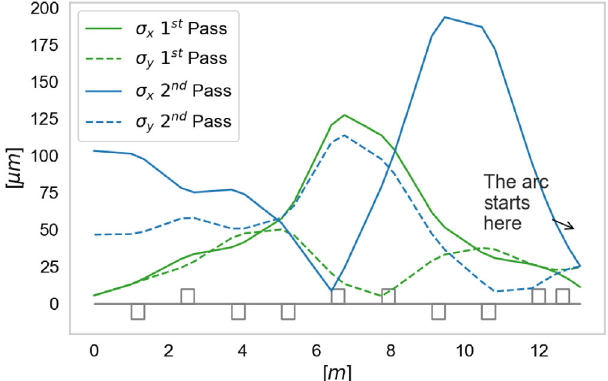
FIG. 7. Beam transverse dimension behaviour: during the matching to the BAC (forward first pass, lighter colors); during the divergences control phase (backward second pass, darker colors).